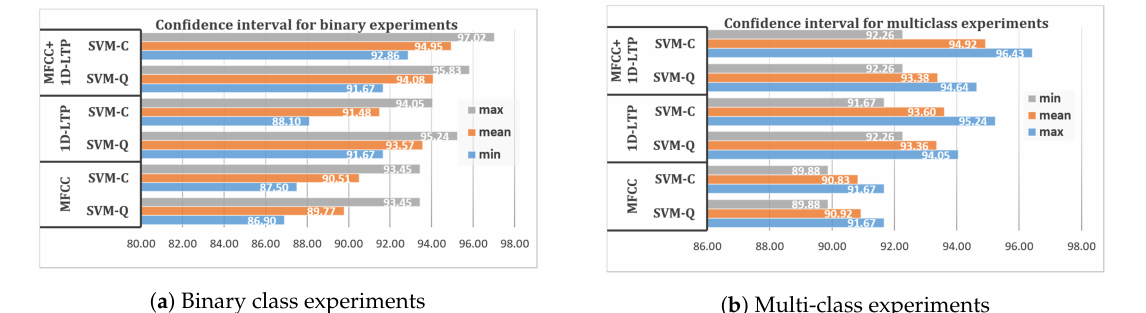
Figure 12. Confidence interval simulation results.